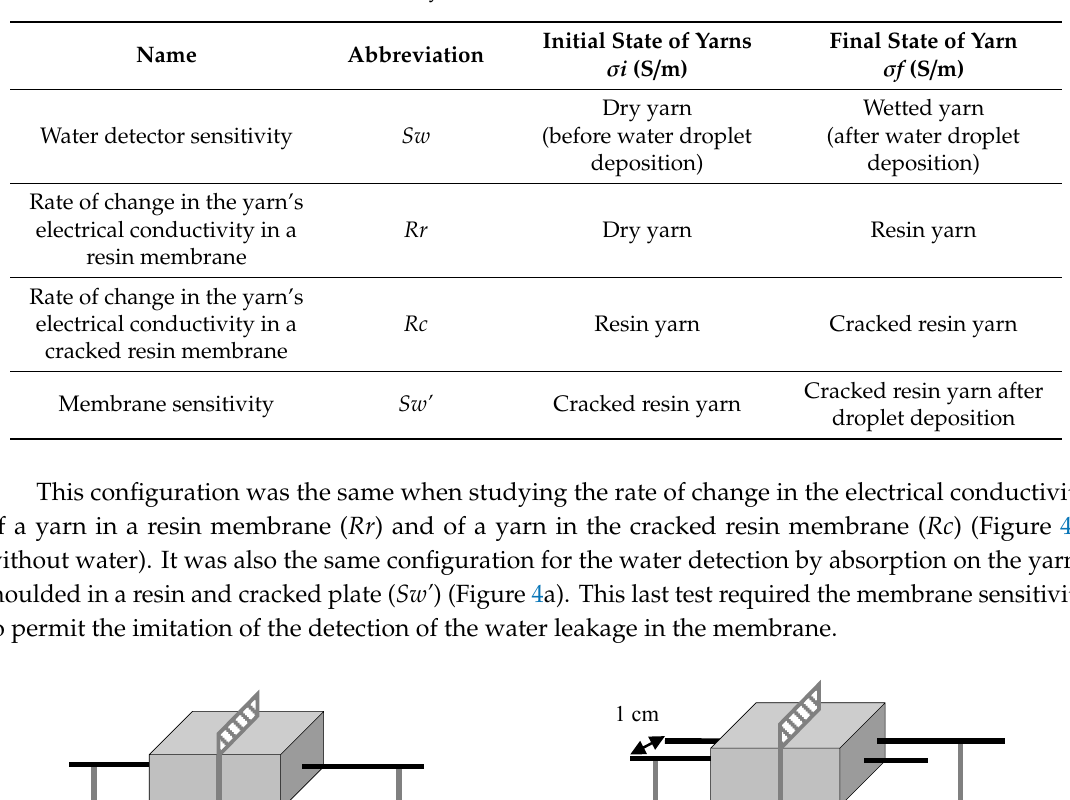
Table 4. Summary of the various sensitivities measured.